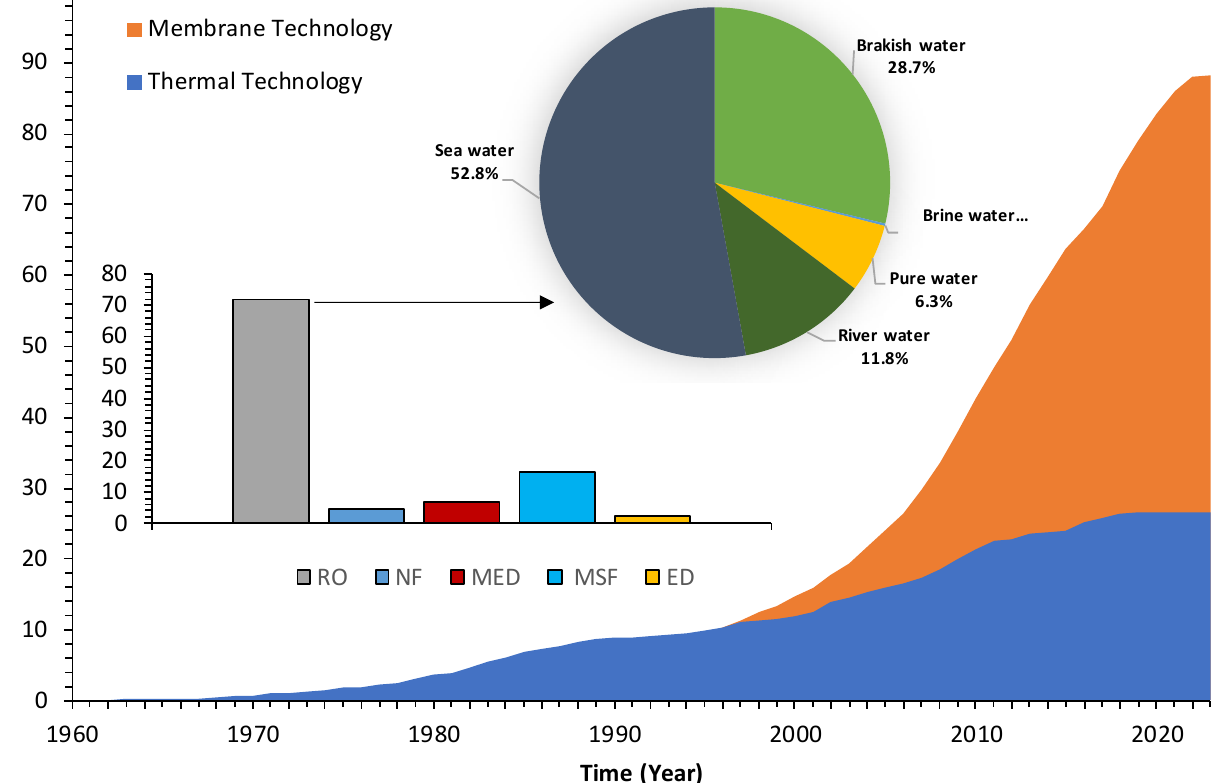
Figure 1. Global desalination capacity with regards to desalination technology and RO source water [3].